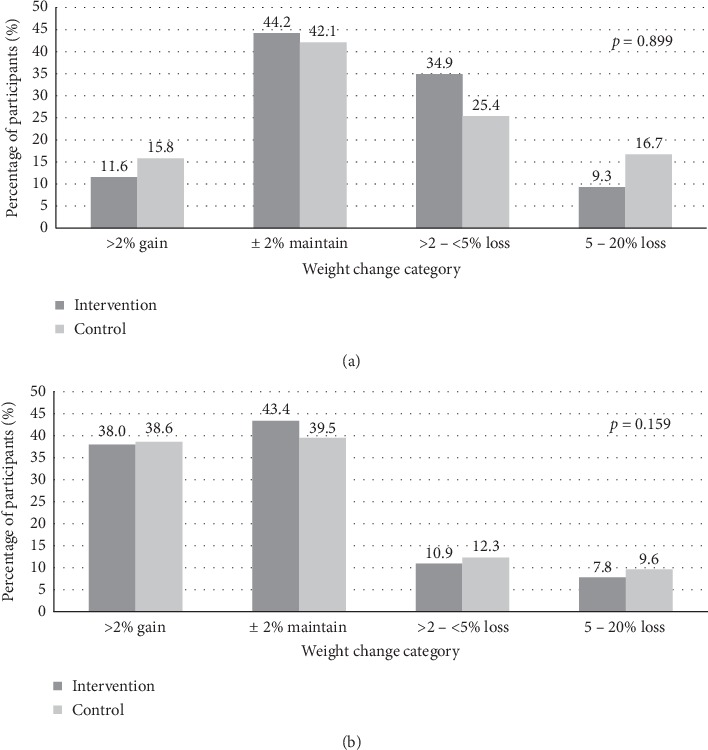
The proportion of participants in the intervention (n = 129) and control (n = 114) groups according to the weight change category during (a) weight loss intervention phase and (b) maintenance phase. Note.p value indicates the statistical significance of the chi-square test used to examine the between-group difference in the proportions of participants with different weight change categories, significant at p < 0.05.